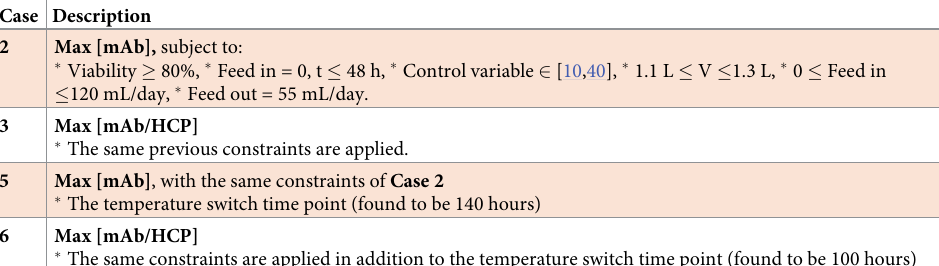
Table 1. A summary of mAb optimisation